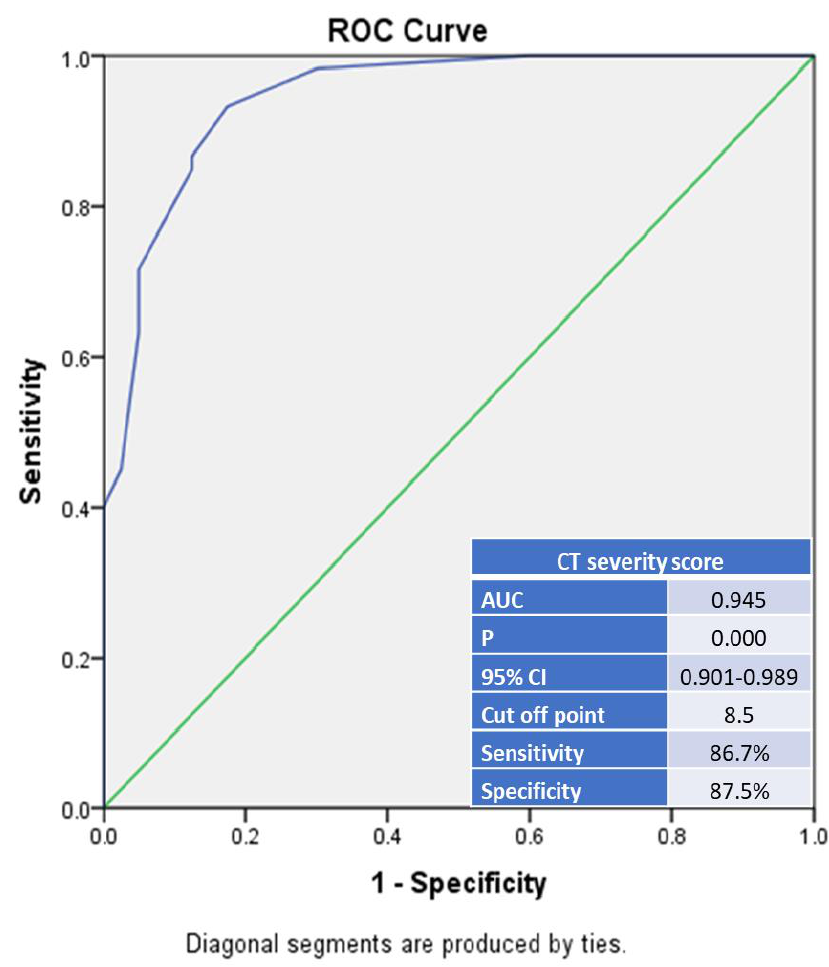
Figure 4. ROC curve for chest CT severity score sensitivity and specificity to predict mortality.